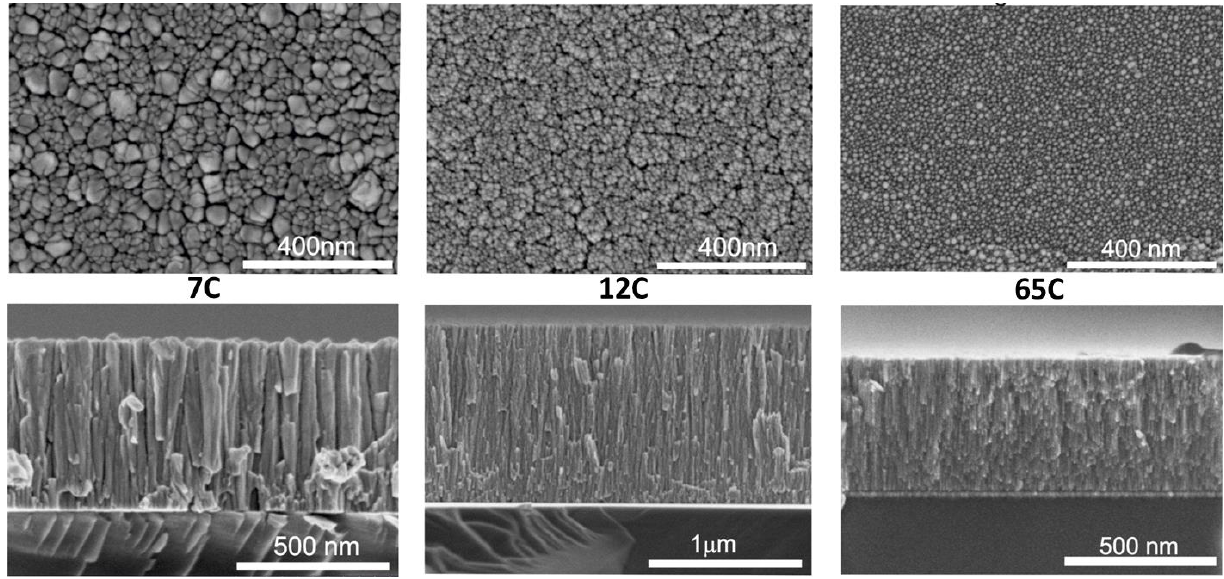
Figure 2. Top- and cross-sectional SEM images of Si-supported Pd-C coatings with different compositions. The XRD patterns for the Si-supported Pd-C films are shown in Figure 3. The Pd (111) peak is marked on the pattern for reference. The samples show a negative shift in the position of these reflections with respect to pure metallic Pd, which can be attributed to the presence of interstitial carbon [50]. The peak positions correlate with those reported for PdC x phases [50], with x < 0.13 for the 7C and x = 0.13–0.15 for the 12C and 65C samples. The 7C and 12C samples show broader and sharper peaks, respectively, as expected from the low and higher power used during the MS deposition. Therefore, the 12C sample contains more and larger crystalline domains derived from the Scherrer equation (see data in Table 2). The 65C sample shows the smallest crystal size (10.2 nm), which is consistent with the lower column width and higher surface roughness observed by SEM and the high C content measured by EDX analysis. This sample was also studied by TEM, as shown in Figure 4, showing the high degree of inter- and intracolumnar porosity, which significantly increases the active surface roughness and area. As complementary information, we have included SEM top-view images at low magnification (Figure S2) for the bare and 65C catalyst-coated SiC foam support. The conformal deposition shows the improved contact surface area for catalysis through the monolithic foam supports. The methodology presented here may also be of interest in regard to highly porous supports (e.g., porous carbons) for catalytic and electrocatalytic [51] applications.